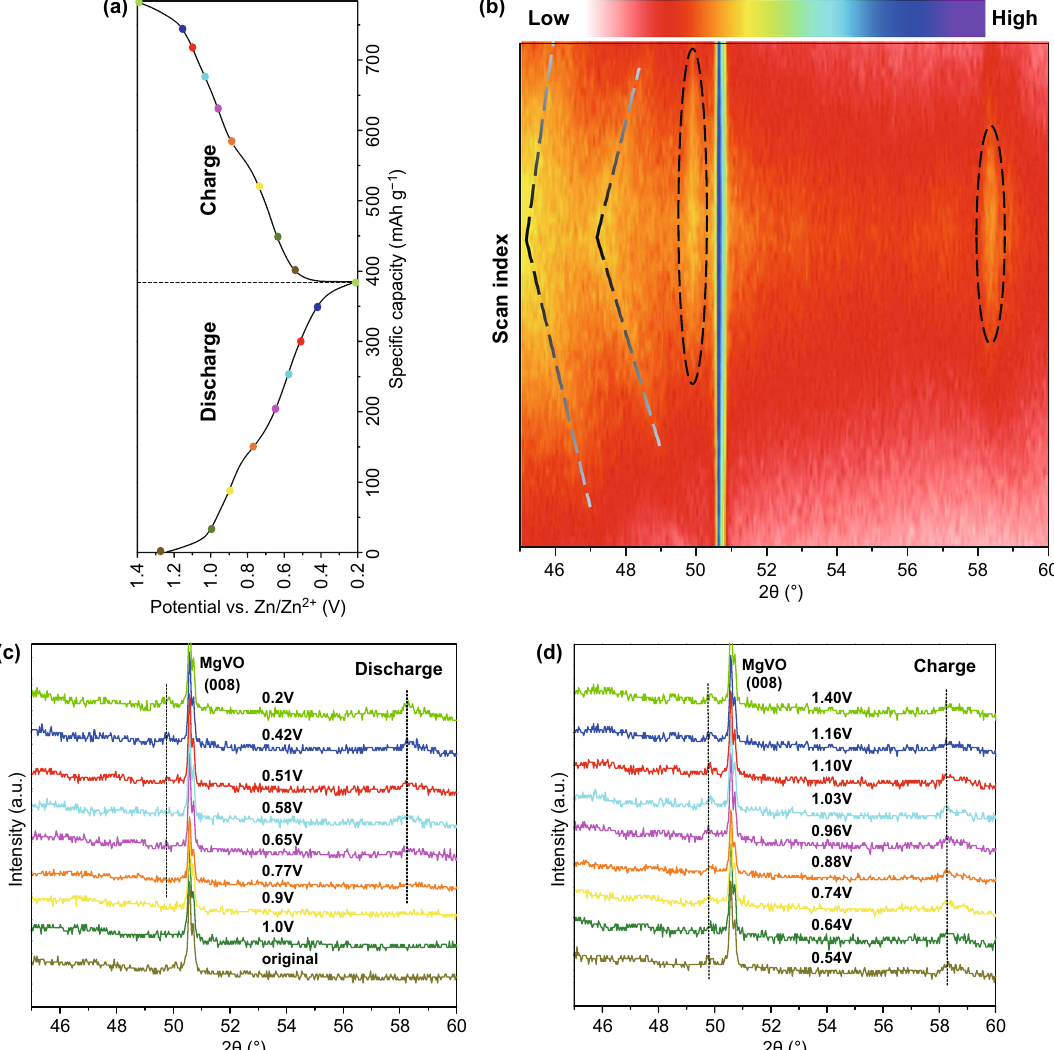
Fig. 5 The first discharge–charge curve ( a ), the corresponding operando XRD patterns in a contour plot ( b ) and the selective XRD patterns at different stages of discharge/charge ( c , d ) obtained at the current density of 100 mA g −1 in 1.0 M ZnSO 4 –1.0 M MgSO 4 electrolyte within a potential window from 0.2 to 1.4